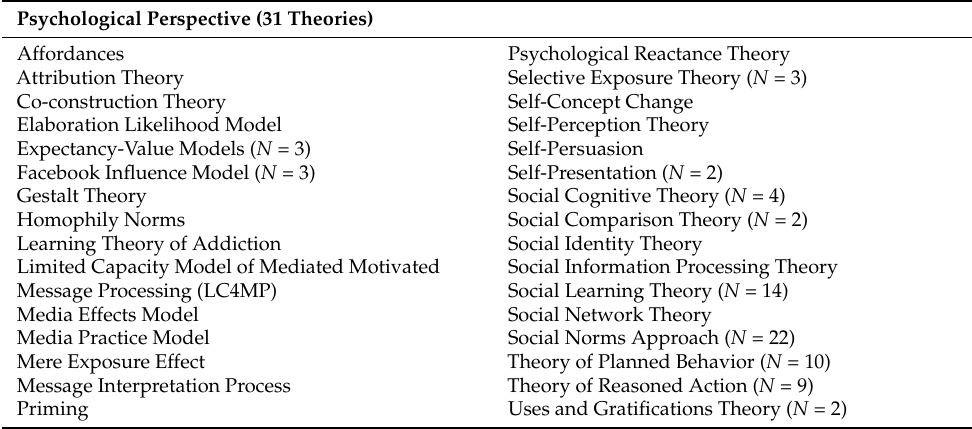
Table 1. List of theories used in 67 of the 204 articles included in the